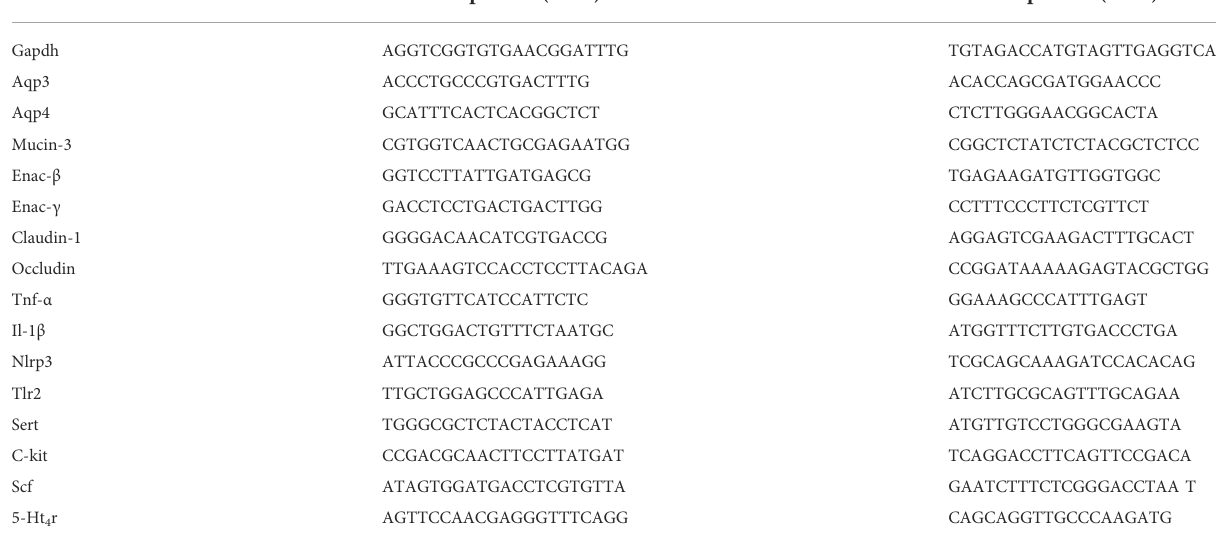
TABLE 1 List of primer sequences for